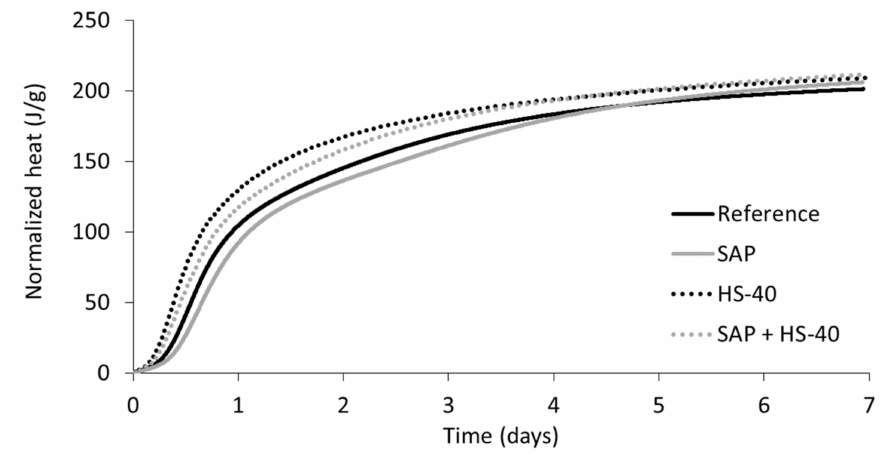
Figure 4. Normalized total heat versus time of cement